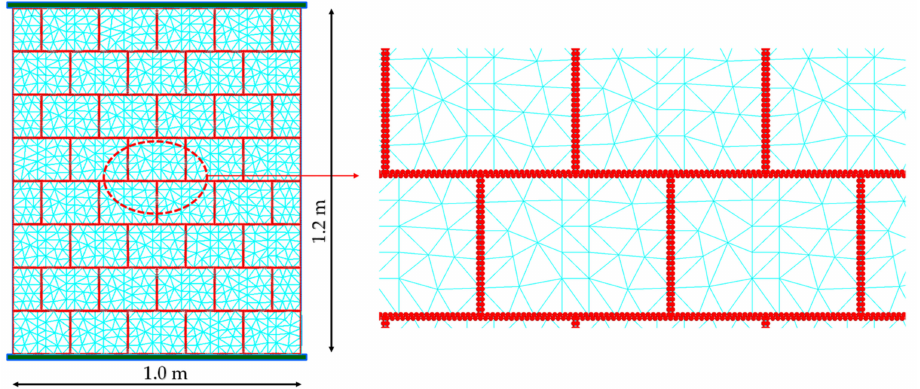
Figure 11. Hybrid discretization for the dry wall